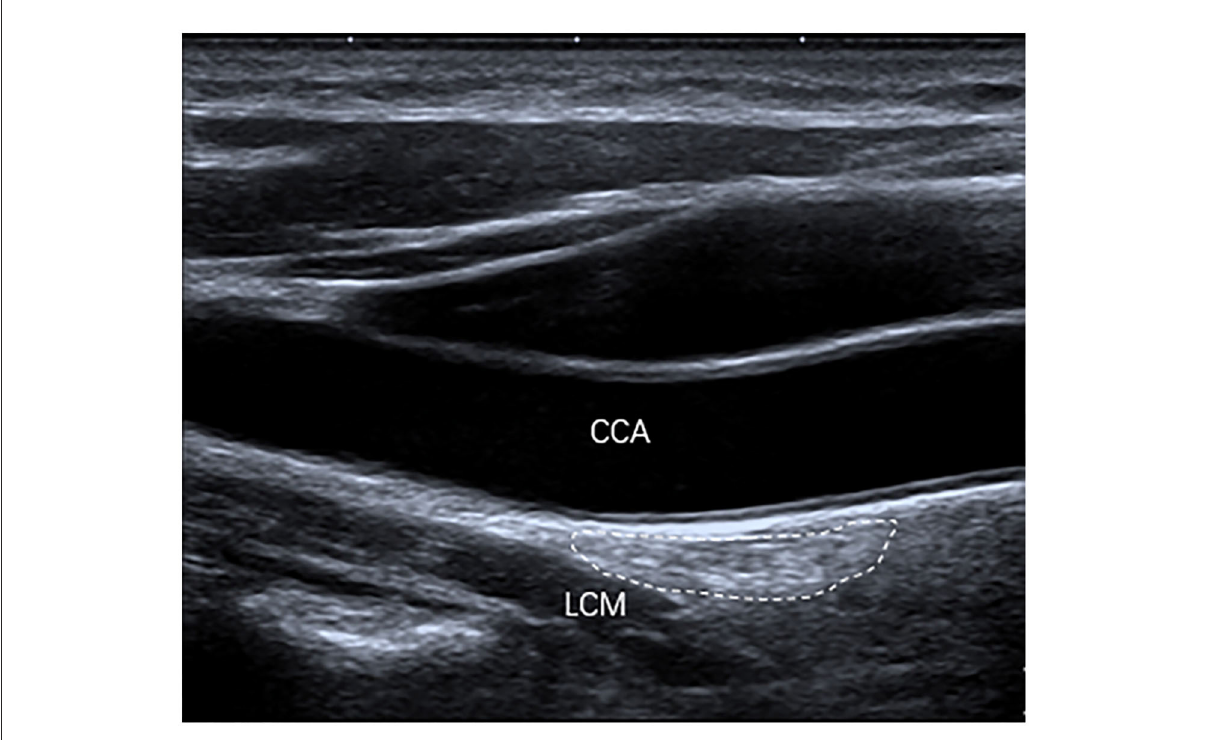
FIGURE2 The SG, with an oval shape (outlined) and hyperechogenicity, was located between the common carotid artery (CCA) and the longus colli muscle (LCM) on the longitudinal ultrasound